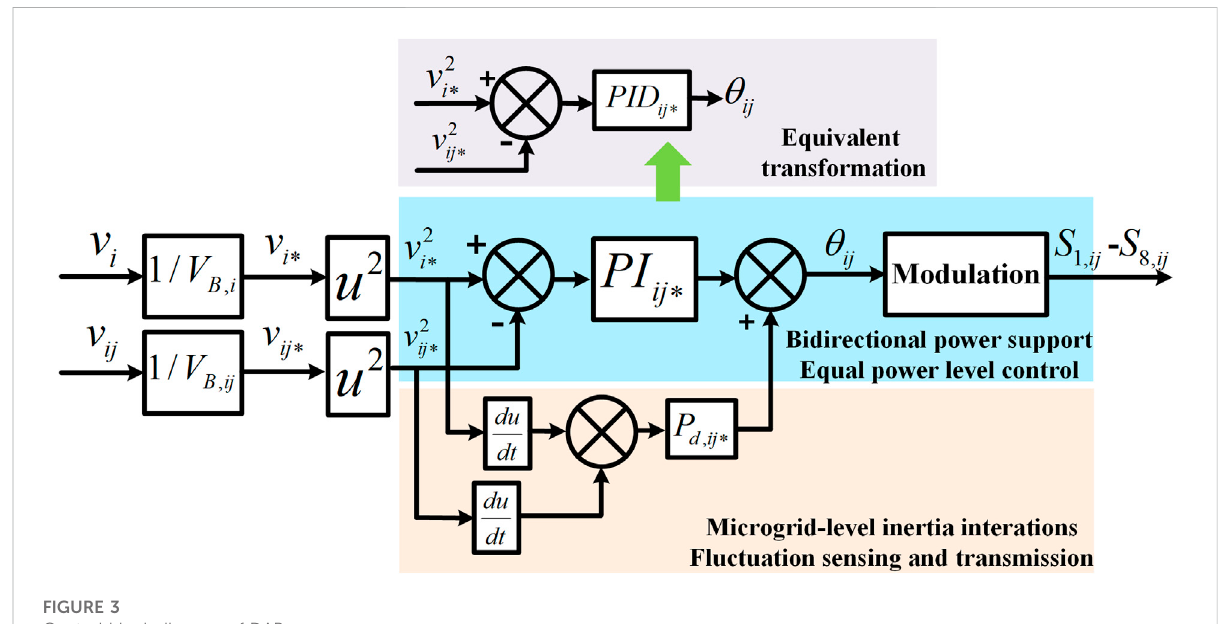
FIGURE 3 Control block diagram of DAB.